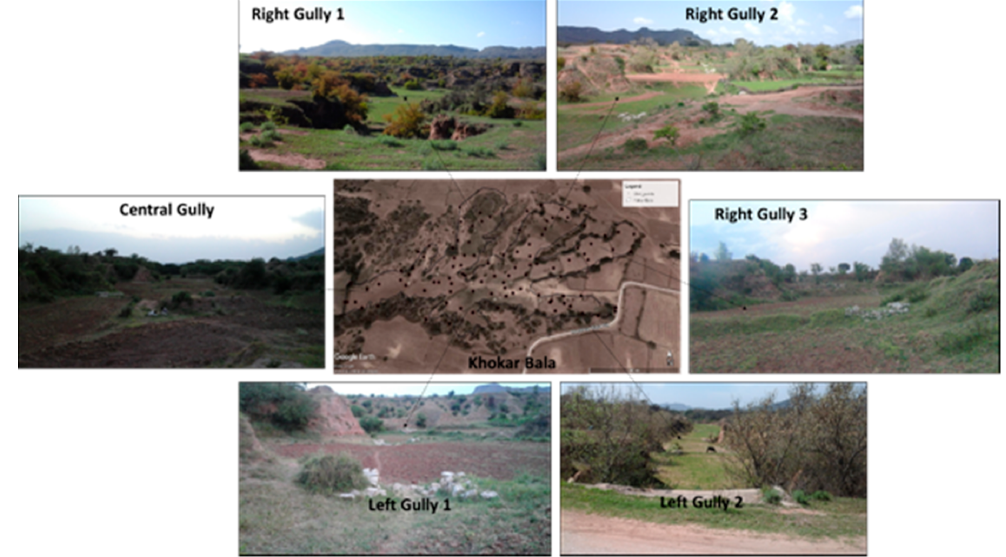
Figure 7. Permanent gullies for the cultivation of crops; an example of Khokar Bala site.